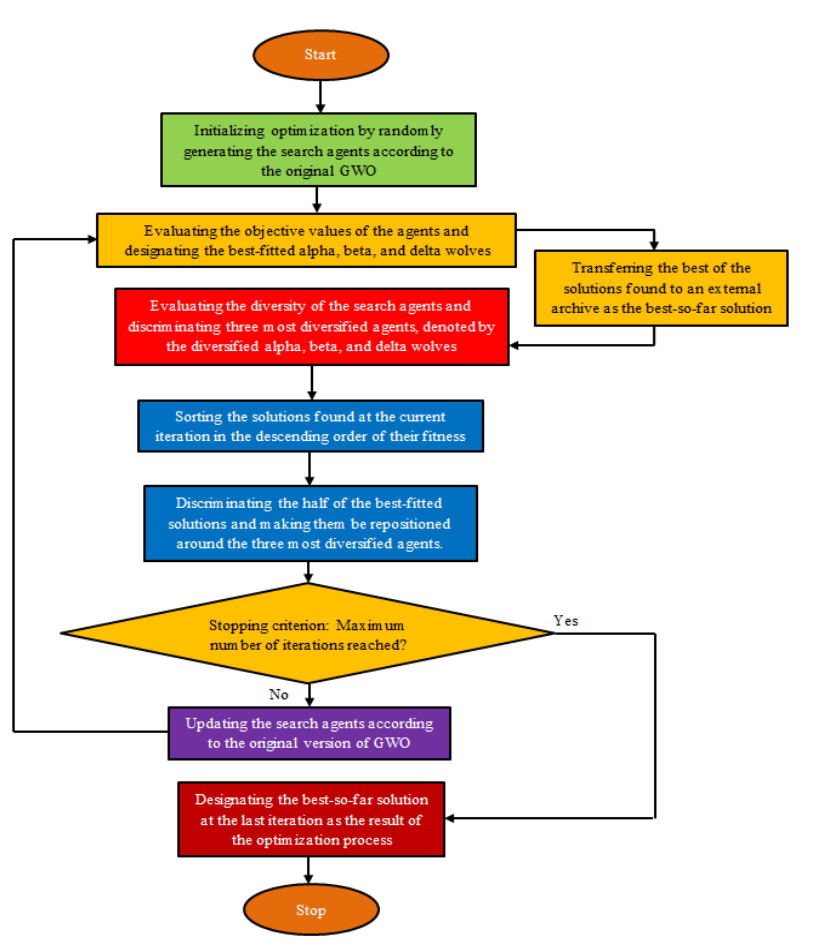
Figure 1. Flowchart of DB-GWO-EPD.